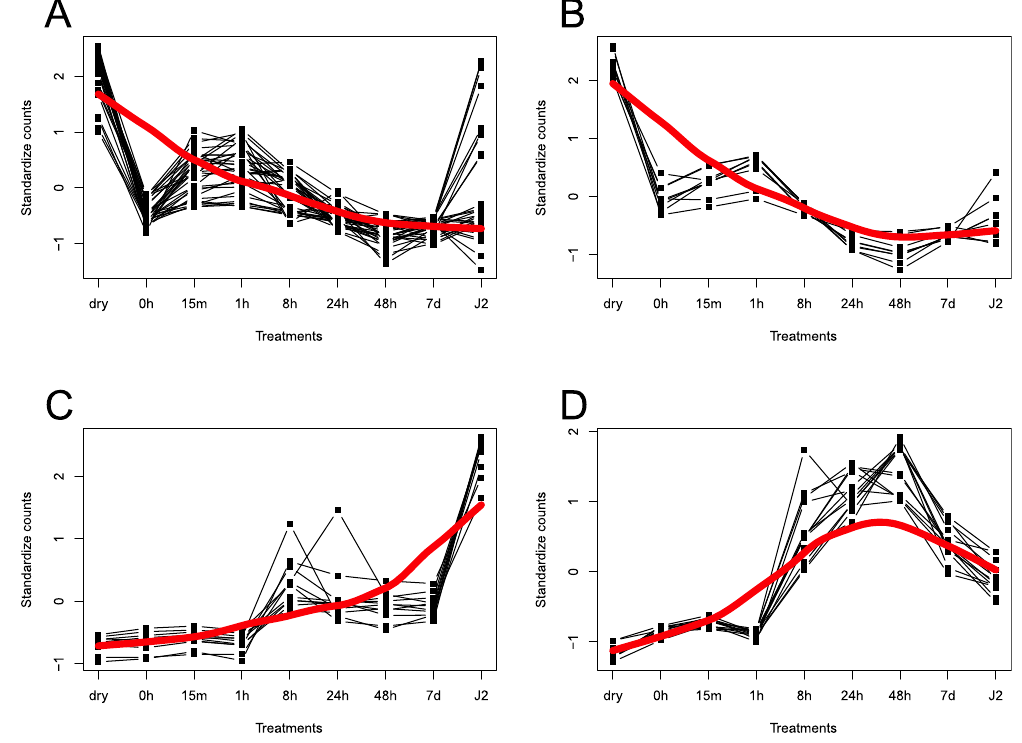
Figure 3. G . rostochiensis expression clusters of interest harboring differentially expressed genes (DEGs) identified with the Trinity transcriptome. ( A ) Cluster containing the trehalose 6-phosphate synthase gene. ( B ) Cluster with a survival-specific expression pattern. ( C ) Cluster containing the nep-1 gene. ( D ) Cluster with a hatching-specific expression